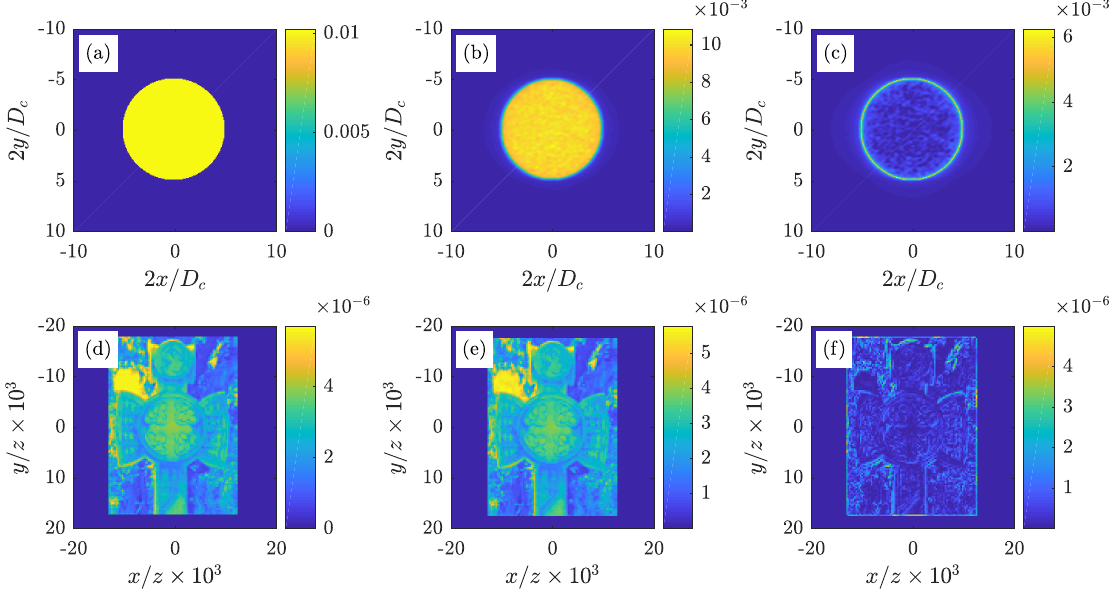
Figure 4. Simulation results demonstrating beam shaping using a spatial filter: ( a ) S out,thy obtained from Equation (16); ( b ) S out,sim ; ( c ) absolute value of the difference of ( a , b ); ( d ) S fz,thy obtained from Equation (22); ( e ) S fz,sim ; and ( f ) absolute value of the difference of ( d , e